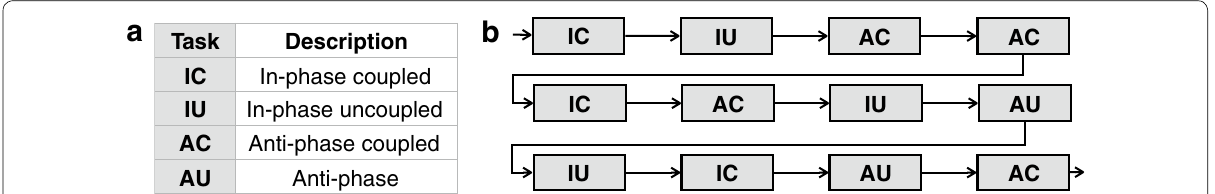
Fig. 2 a The four task conditions defined as combinations of the phase and coupling conditions. For a given task, the same movement is repeated five times. b In the block design of the experiment, each of the four tasks was repeated five times in a pseudo-random order